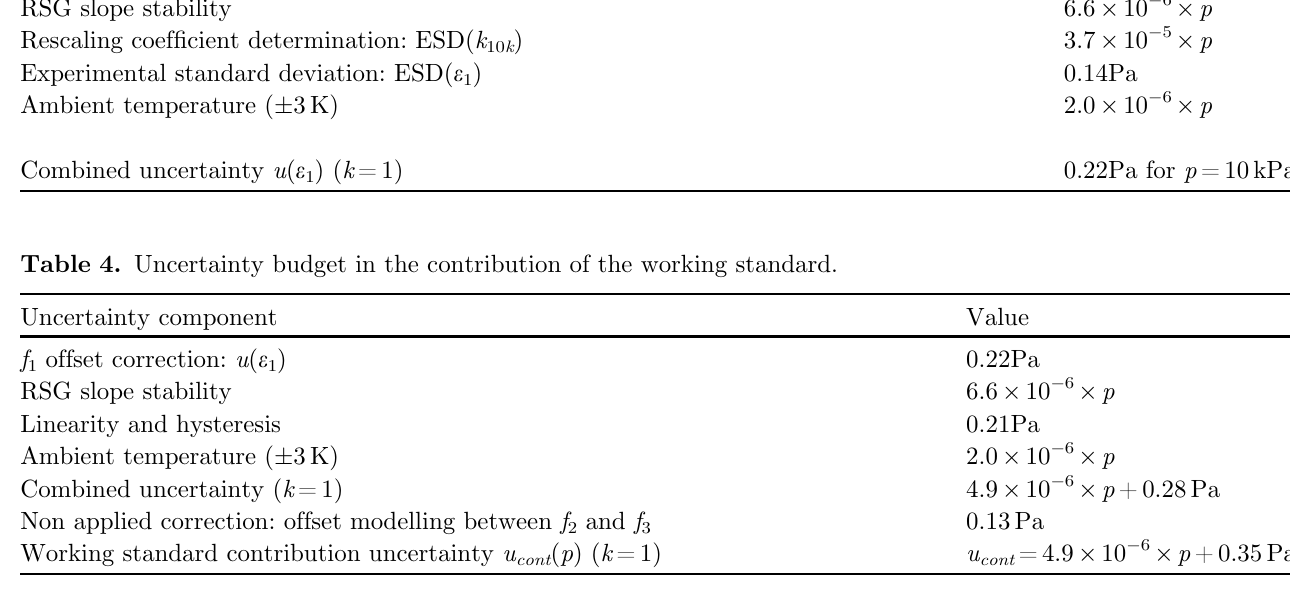
Table 3. Uncertainty budget in the determination of e